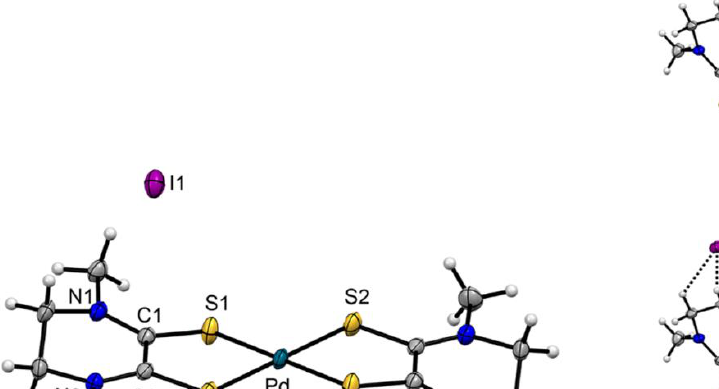
Figure 1. ( a ) Molecular structure of complex [Au(Me 2 pipdt)I 2 ]I 3 ( 1 ) with thermal ellipsoids plotted at the 50% probability level. ( b ) Portion of the crystal packing, showing intermolecular interactions as dashed bonds. Selected interaction distances (Å ) and angles are indicated. Table 1. Selection of bond distances (Å ) and angles (°) for compounds [Au(Me 2 pipdt)I 2 ]I 3 ( 1 ) and [Pd(Me 2 pipdt) 2 ](I) 2 ( 2a ).